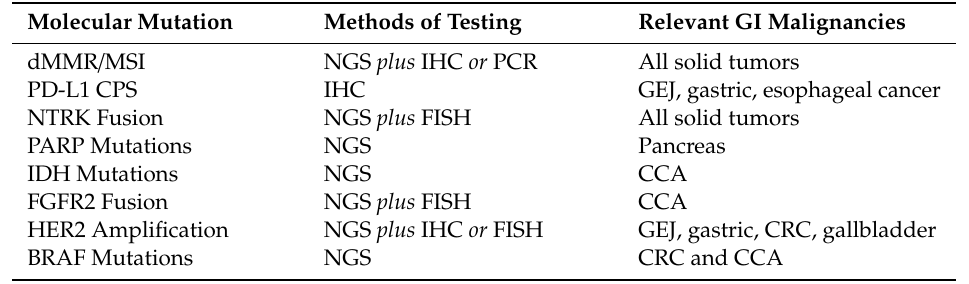
Table 1. Methods of molecular testing for genetic mutations mentioned and relevant malignancies. Poly (adenosine diphosphate–ribose) polymerases (PARP), isocitrate dehydrogenase (IDH), and BRAF mutations can be detected by next generation sequencing (NGS) alone, whereas deficient mismatch repair (dMMR) / microsatellite instability (MSI), NTRK, FGFR2, and HER2 require additional testing for confirmation of positivity. PD-L1 combined positive score (CPS) can be calculated from